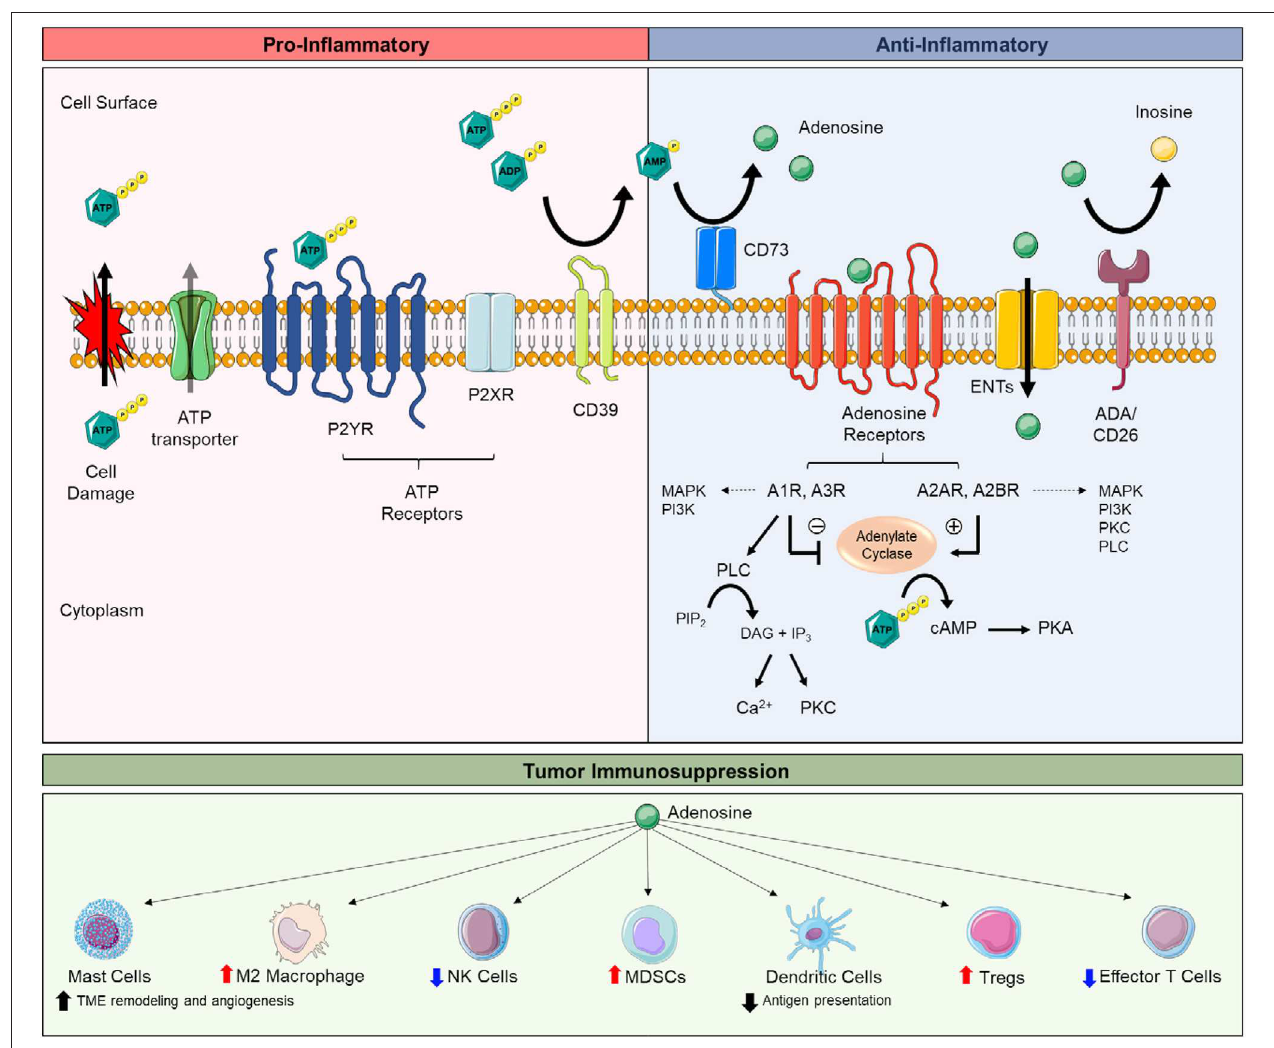
FIGURE 1 | Extracellular adenosine synthesis, adenosine receptor signaling, and adenosine-mediated immunosuppression. Extracellular adenosine and receptor signaling is part of a large cascade of ecto-enzymes (e.g., CD39, CD73), membrane transporters (e.g., ENTs), and G-protein-coupled (e.g., P2YR, adenosine receptors) and ionotrophic receptors (e.g., P2XR) known as the purinergic pathway. The purinergic pathway mediates both pro-inflammatory and anti-inflammatory responses. The breakdown of extracellular adenosine triphosphate (ATP) to extracellular adenosine is key to balancing tissue inflammation. Intracellular ATP is released by lytic (e.g., stressed and/or apoptotic/necrotic cells) and non-lytic (e.g., pannexin-1 and connexins) routes secondary to tissue damage, inflammation, and/or hypoxia. Once released, ATP activates ATP receptors (e.g., P2XR and P2YR) to promote pro-inflammatory responses, including the release of inflammatory cytokines promote lymphocyte proliferation, cell mobility, and phagocyte recruitment. ATP is dephosphorylated to extracellular adenosine by CD39, converting ATP and adenosine diphosphate (ADP) to adenosine monophosphate (AMP), and CD73, converting AMP to adenosine. Extracellular adenosine signaling through adenosine receptors (e.g., A1R, A2AR, A2BR, A3R) promotes anti-inflammatory responses, including the release of pro-tolerance cytokines, regulatory lymphocytes, and skewing toward M2 macrophages. Extracellular adenosine also can be taken up intracellularly by equilibrative nucleoside transporters (e.g., ENTs) or be further metabolized to inosine (e.g., ADA/CD26). A2AR and A2BR signaling stimulate adenylate cyclase to produce cyclic AMP (cAMP) which activates protein kinase A (PKA). A1R and A3R signaling inhibit adenylate cyclase. Adenosine receptors can activate multiple signaling pathways (e.g., MAPK, PI3K, PLC, PKC, ion channels), depending on cell and tissue types. Tumors exploit the anti-inflammatory actions of extracellular adenosine to evade antitumor immune cells. A3R activation on mast cells promotes tumor microenvironment (TME) remodeling and angiogenesis, increases the population of M2 macrophages, and promotes the accumulation of myeloid-derived suppressor cells (MDSCs) in tumors. A2AR activation on T regulatory cells (Tregs) enhances their immunosuppressive activity (e.g., suppressing effector T cells). A2AR and/or A2BR activation on natural killer (NK) cells, dendritic cells, and effector T cells dampens the antitumor activity of these cells. Abbreviations: ectonucleoside triphosphate diphosphohydrolase-1 (CD39), ecto-5 ′ nucleotidase (CD73), adenosine deaminase (ADA), phospholipase C (PLC), protein kinase C (PKC), diacylglycerol (DAG), phosphatidylinositol 4,5-bisphosphate (PIP 2 ), inositol trisphosphate (IP 3 ), mitogen-activated protein kinase (MAPK), phosphoinositide 3-kinase (PI3K).